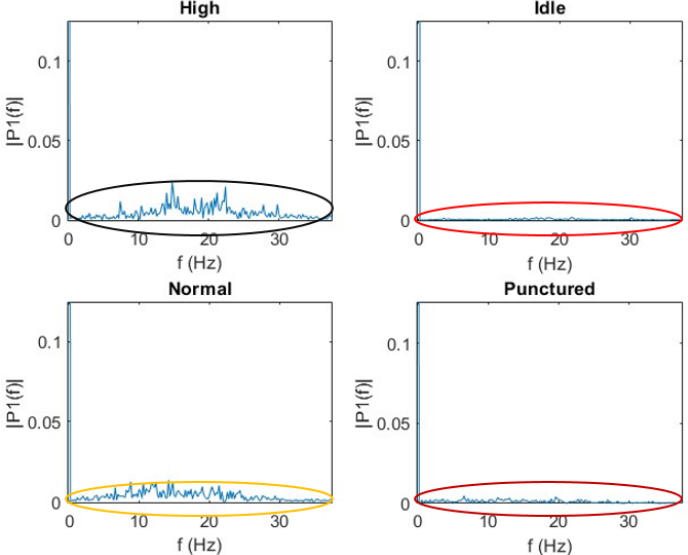
Figure 5. FFT image for vibration signals of different conditions used.